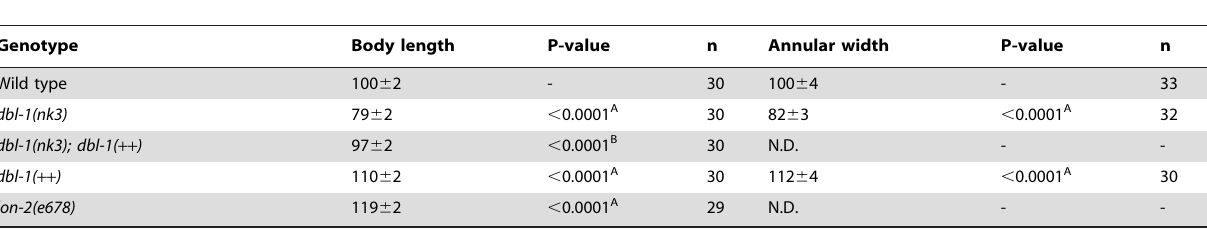
Table 1. DBL-1 is a dose-dependent regulator of body length and annular